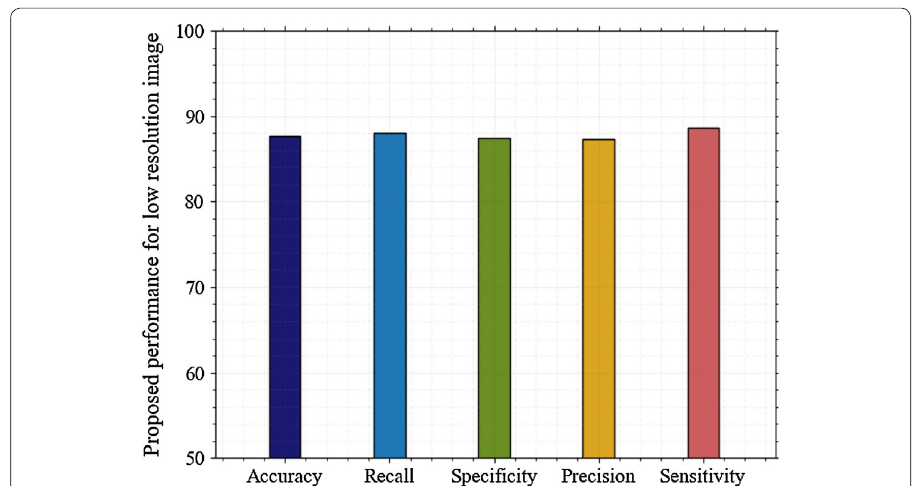
Fig. 14 Low resolution for accuracy, recall, specificity, precision and sensitivity